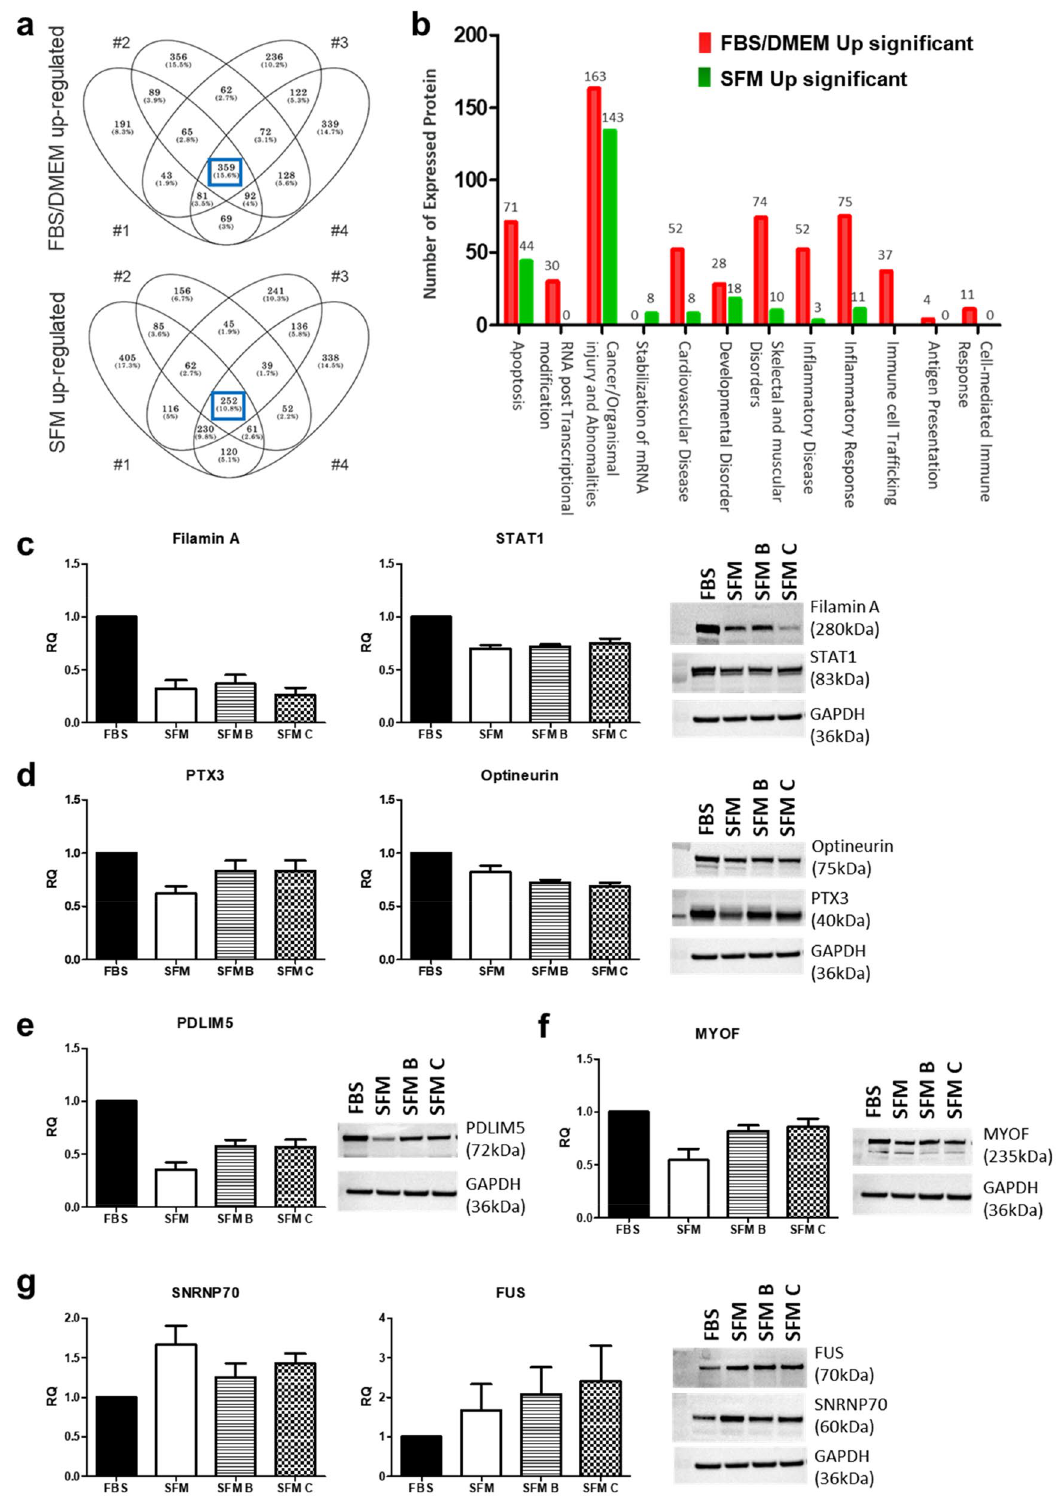
Figure 4. Comparison of protein expression profile. Protein identification and abundance were detected by LC–MS/MS. ( a ) Protein expression in ADSCs from four donors grown in the two different media, showed up-regulation of 252 proteins in ADSCs cultured in SFM and 356 proteins in ADSCs cultured in FBS. ( b ) Up-regulated proteins in group FBS were involved in apoptosis, cardiovascular disease, skeletal and muscular disorders, inflammatory response, immune cell trafficking, and cell-mediated immune response. Functional classification analysis validated by western blot after cell expansion in the FBS containing media and three different SFMs included ( c ) apoptosis, ( d ) inflammatory response, ( e ) cardiovascular disease, ( f ) skeletal and muscular disorders, ( g ) mRNA stabilization. Data are represented as the mean ± SEM. ADSC adipose-derived stem cell, SFM serum free media, FBS fetal bovine serum, STAT1 signal transducer and activator of transcription 1, PDLIM5 PDZ and LIM domain 5, MYOF Myoferlin, SNRNP70 small nuclear ribonucleoprotein U1 subunit 70, SFM, SFM B, and SFM C are CellCor, StemPro, and MesenCult,